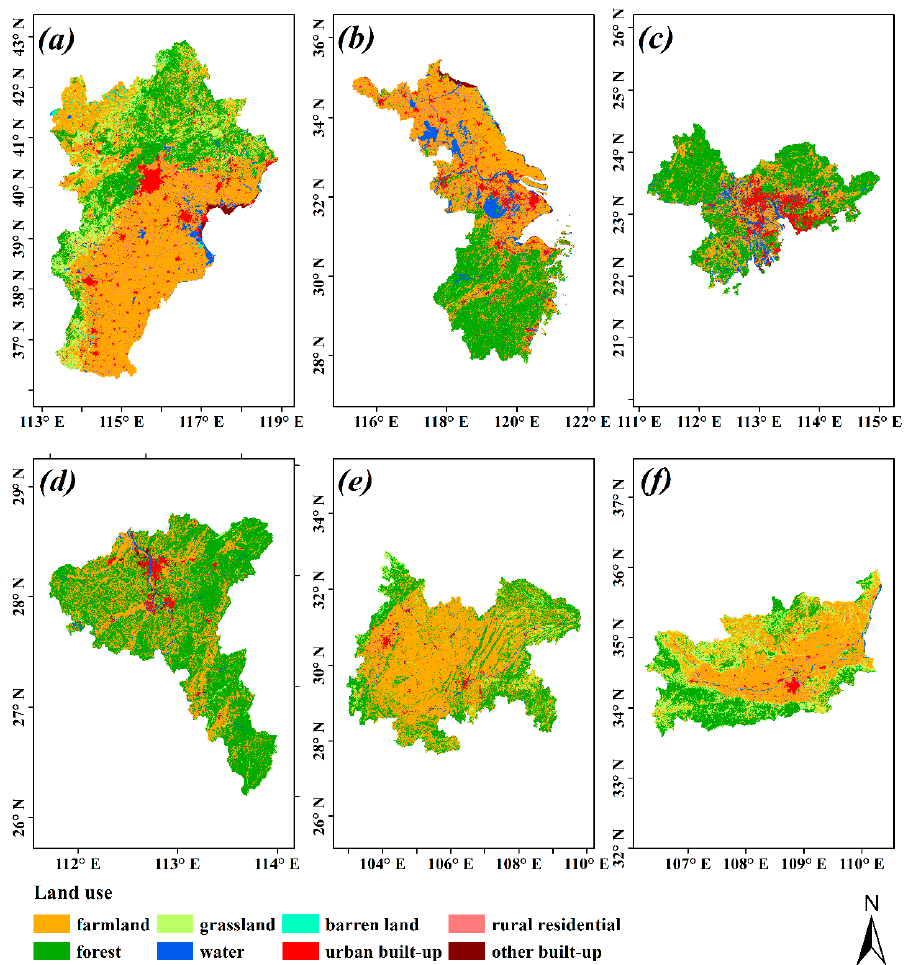
Figure 2. Spatial pattern of land use of ( a ) the Jing-Jin-Ji region; ( b ) the Yangtze River Delta; ( c ) the Pearl River Delta; ( d ) the Chang-Zhu-Tan; ( e ) the Chengdu-Chongqing; and ( f ) the Guanzhong urban agglomerations in 2013.